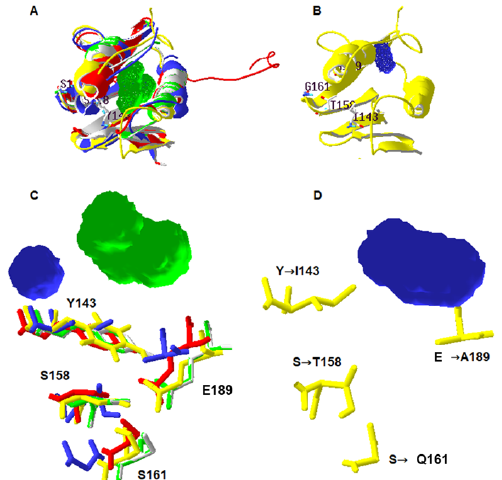
Figure 5. Structural analysis of frataxin. ( A , C )—Superimposed structures of frataxin from human (yellow), E. coli (blue), S. cerevisiae (red), R. prowazekii (green), and R. tiphi (gray). ( B , D )—Optimized structure of mutated human frataxin. The cavity in prokaryotic frataxins is represented by the green blob in panel ( C ). In the same panel, we also represent the cavity found in Rickettsia’s frataxin. The blue blob in panels ( B , D ) represents the cavity that arise in human frataxin when cluster three residues are mutated to those of E. coli. The blue cavity in panel ( D ) overlaps with the green cavity in panel ( C ) to a high extent .